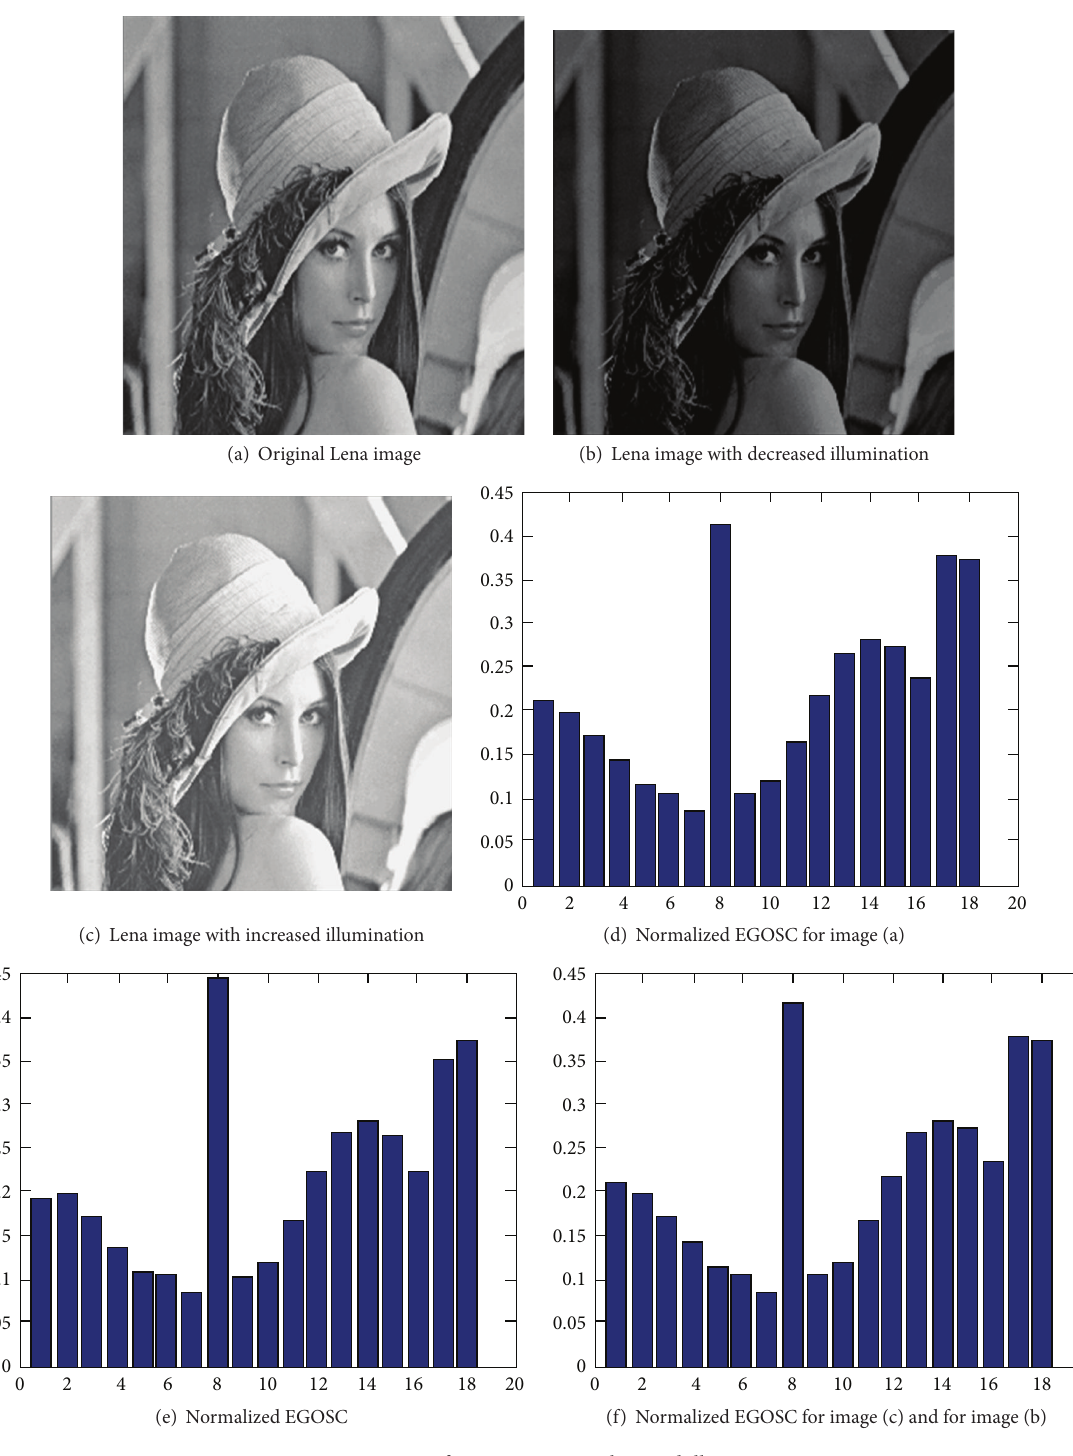
Figure 5: EGOSC for Lena image with varied